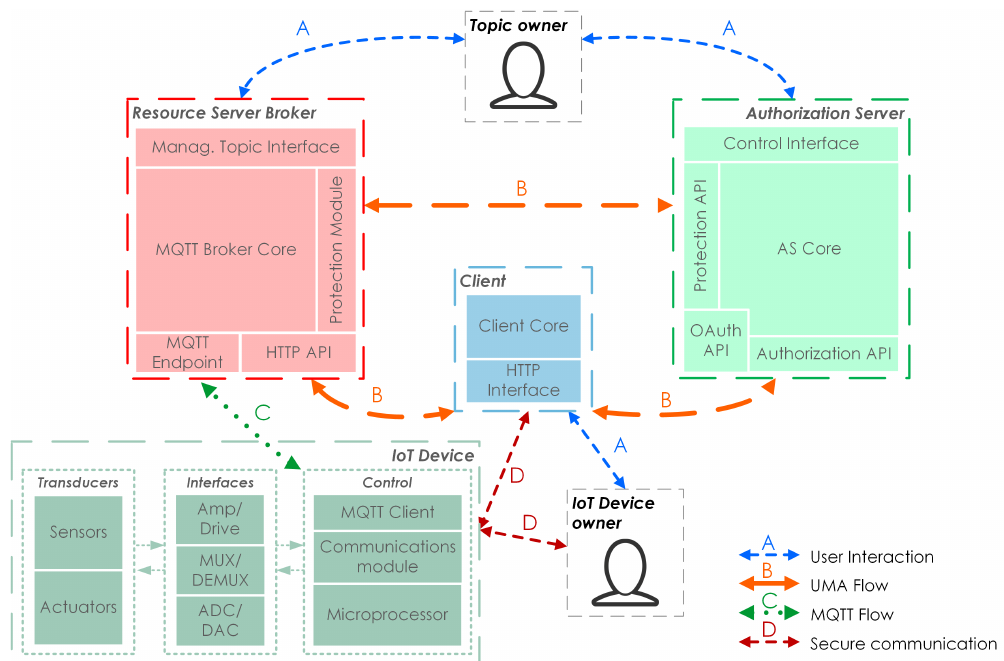
Figure 3. The main diagram of the proposed solution. ADC: Analog to Digital Converter; DAC: Digital to Analog Converter; DEMUX: Demultiplexer; HTTP: Hypertext Transfer Protocol; IoT: Internet of Things; MUX: